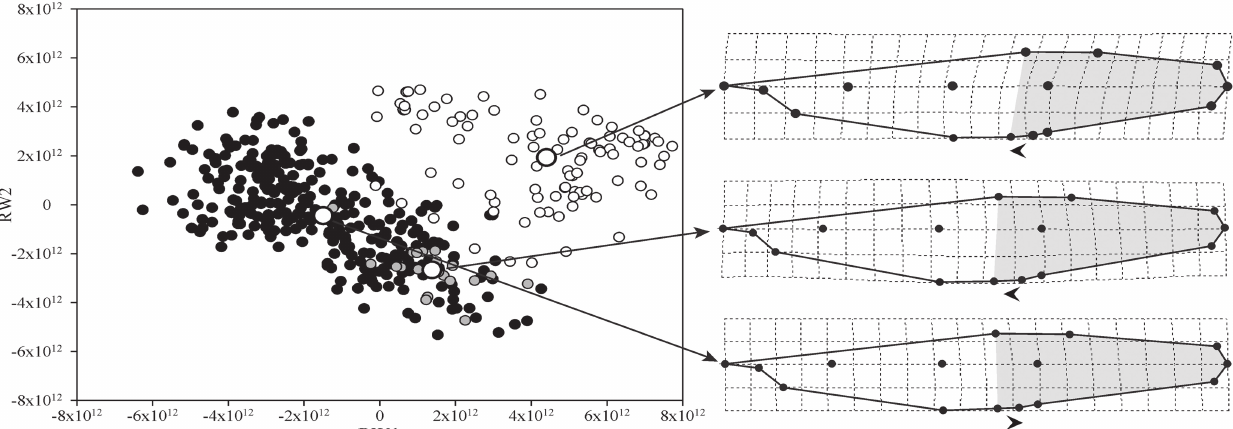
Fig. 4. Geometric Morphometric Analysis applied to Odontesthes individuals. RW2 versus RW1 and deformation grids (tied to group means) for Odontesthes bonariensis (white circle) , O. hatcheri (black circle) and presumptive hybrids (gray circle). Arrowheads indicate displacement of landmarks relative to consensus. Shaded area shows relative position of landmarks 5 (anterior insertion of the first dorsal fin) and 12 (distal tip of the pelvic fin onto fish body).